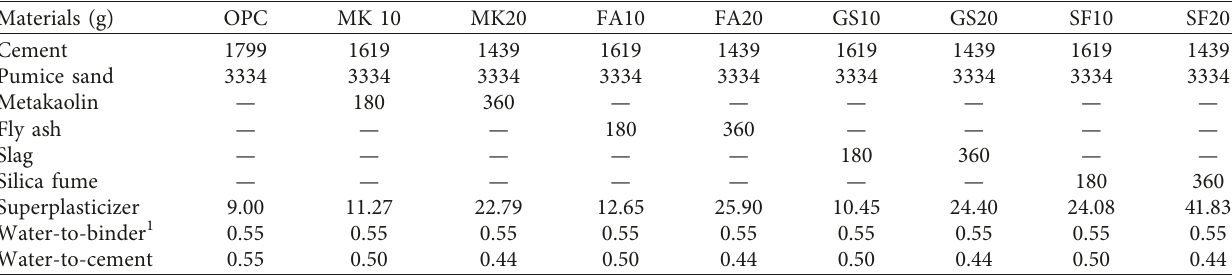
Table 3: Mortars’ mix design.